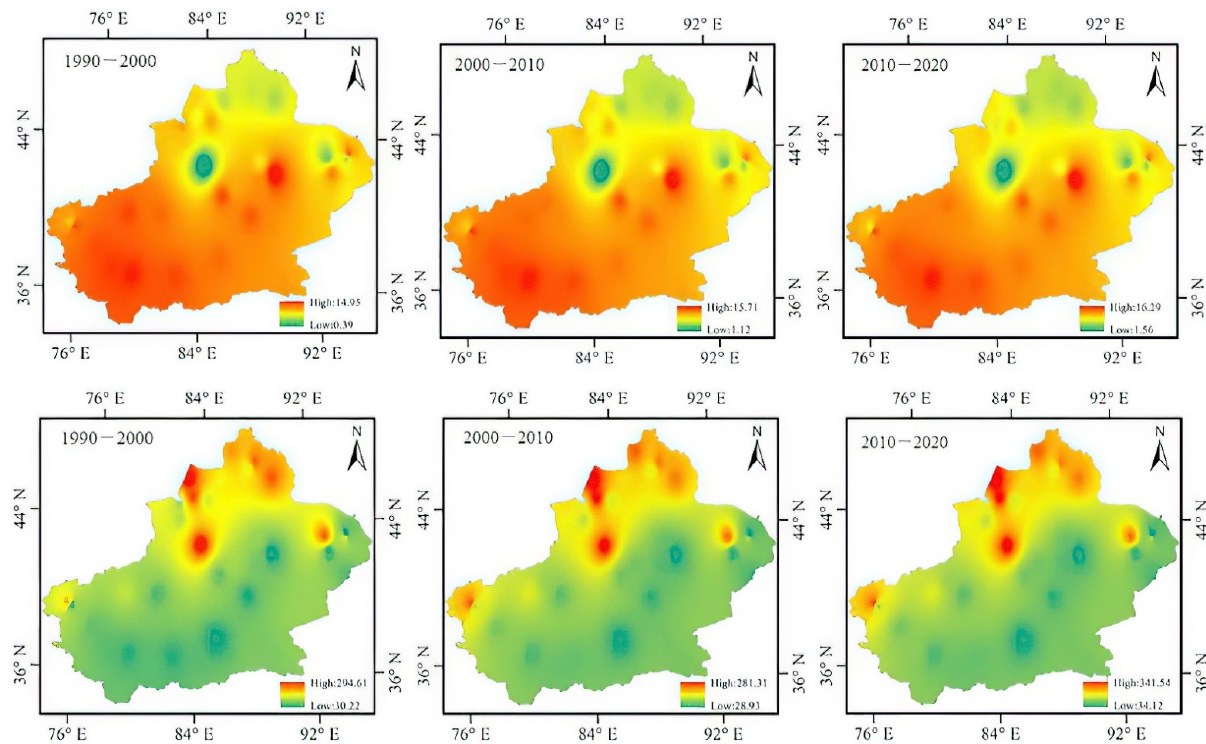
Figure 5. Distribution characteristics of the spatial variation of temperature and precipitation in Xinjiang from 1990 to 2020.